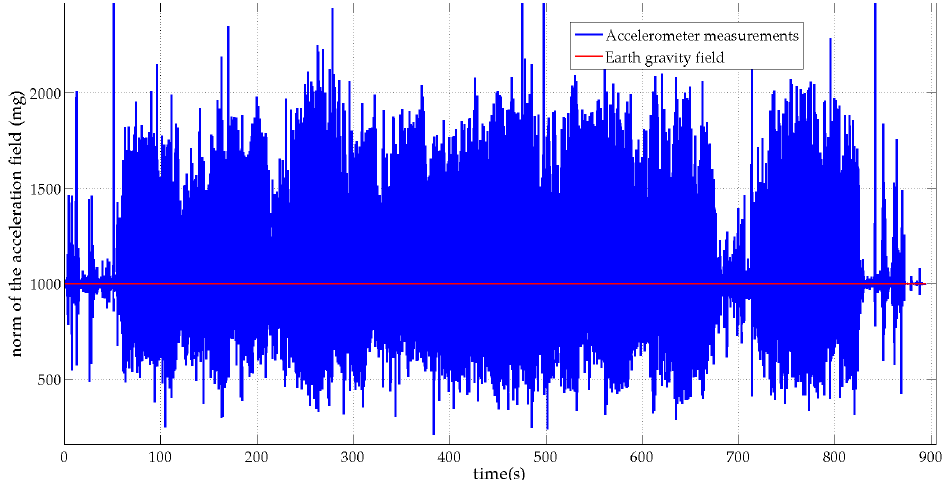
Figure 3. Norm of the MIMU’s acceleration vector (blue) and the Earth gravity field (red).